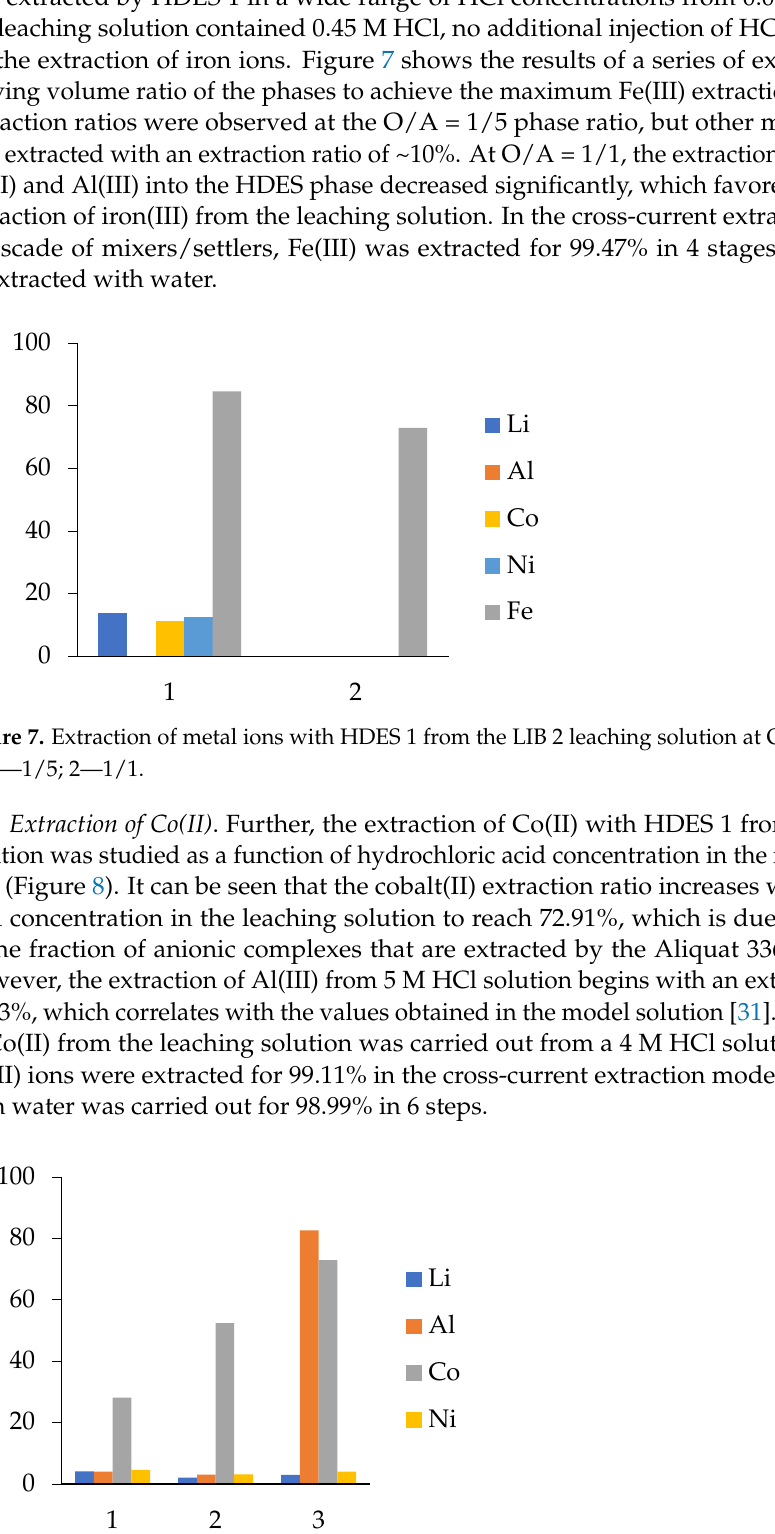
Figure 8. Extraction of Li(I), Co(II), Ni(II) and Al(III) ions with HDES 1 from the raffinate after stage 1 as a function of HCl concentration, M: 1–3, 2–4, 3–5.